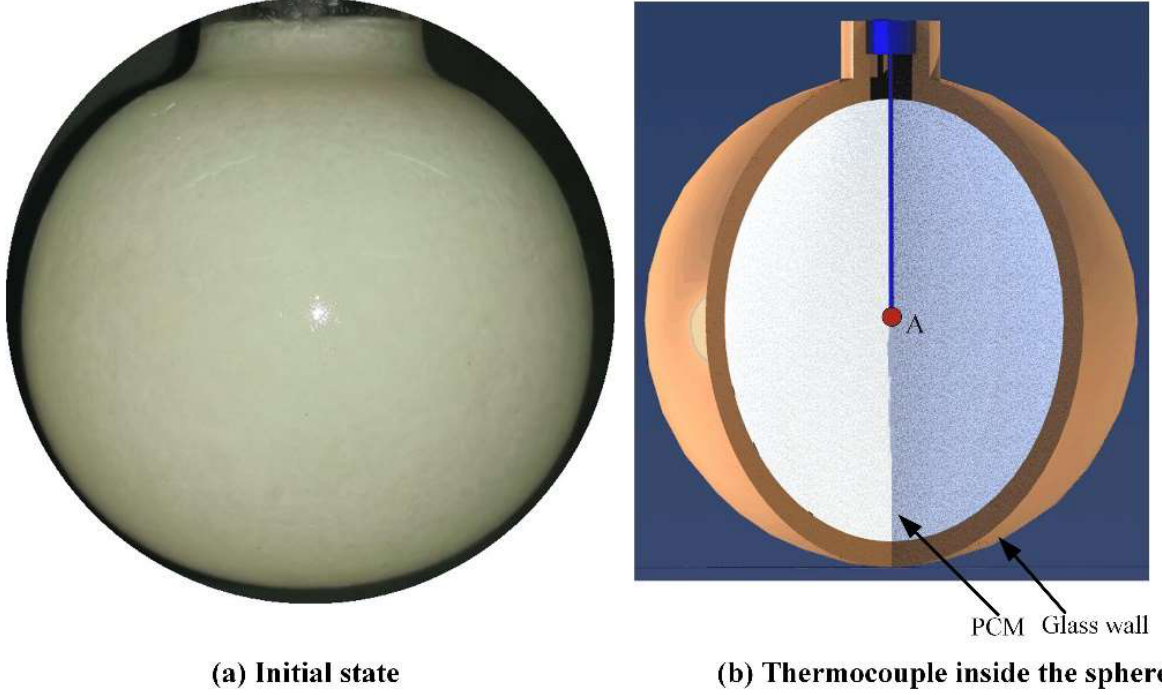
Figure 2. ( a ) The spherical enclosure filled with paraffin wax and ( b ) the schematic diagram of the constrained computational domain embedding with a thermocouple located at the center of the sphere.